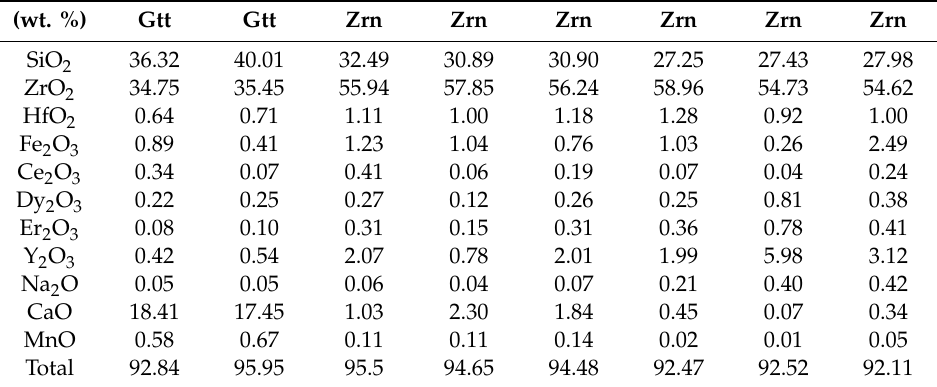
Table 5. Exemplary analyses of gittinsite and zircon crystals of the metasomatic samples. (wt. %)